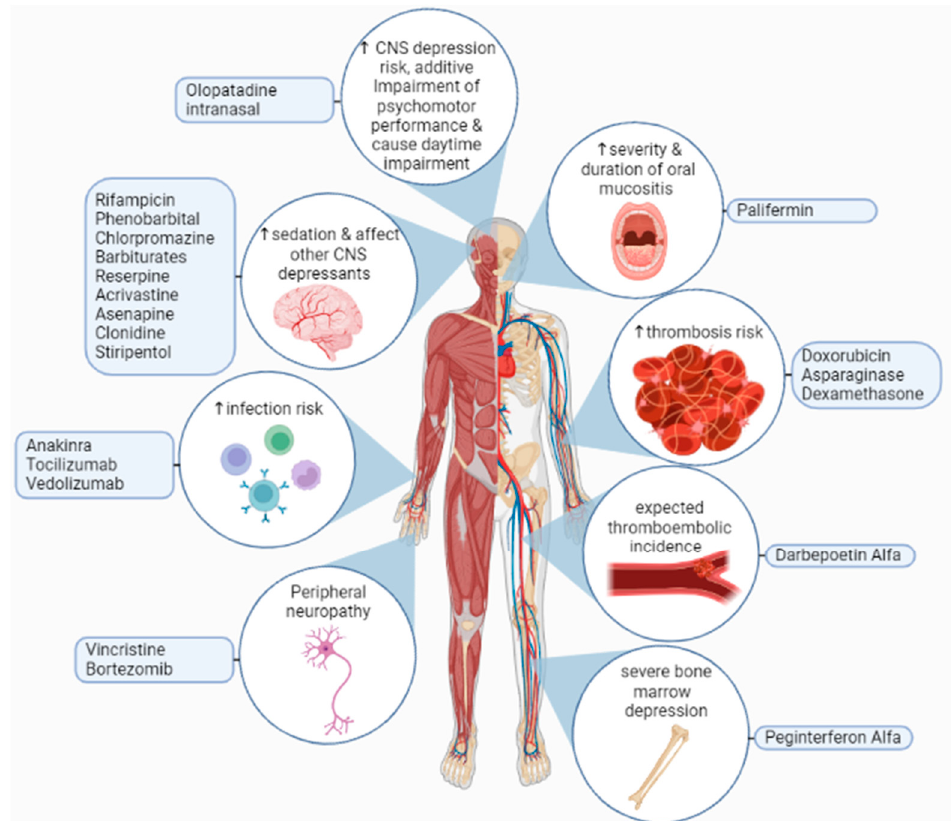
Figure 4. Adverse effects of thalidomide interactions with other drugs may lead to an increased risk of infection, thrombosis, oral mucositis, neurological toxicities, severe bone marrow depression, or increases in the sedative effect of other central nervous system depressants. Furthermore, olopatadine intranasal increases the risk of central nervous system depression, which leads to additive impairment of psychomotor performance, and causes daytime impairment [163–165].